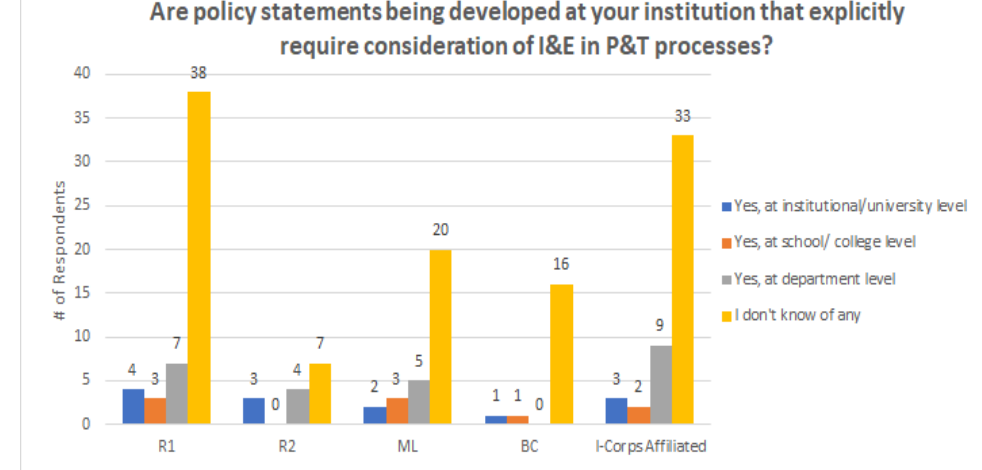
Figure 9. Comparison of institution type responses of the level where I&E related P&T policy statements apply at their institutions.